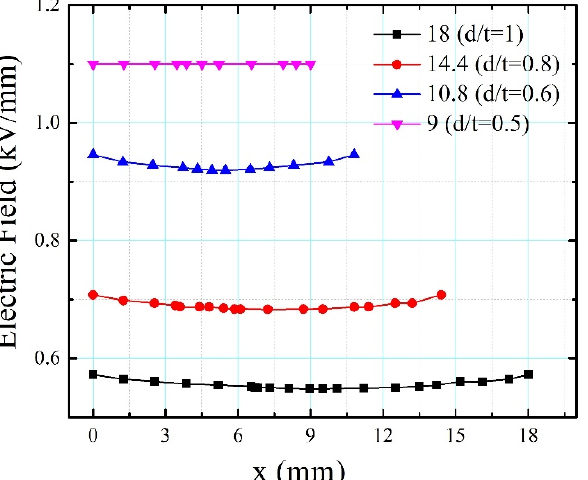
Figure 6. Spatial variation of E ( x ) in gap for different d/t ratios (where x is any point in the inter- electrode gap).